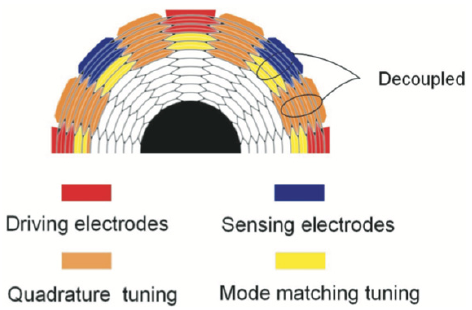
Figure 6. Honeycomb disc resonant gyro developed by the National University of Defense Technol- ogy.